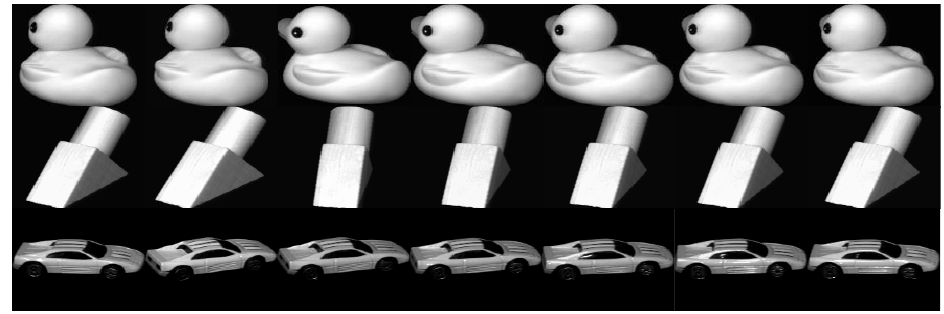
Figure 2. Examples of three objects from the COIL-20